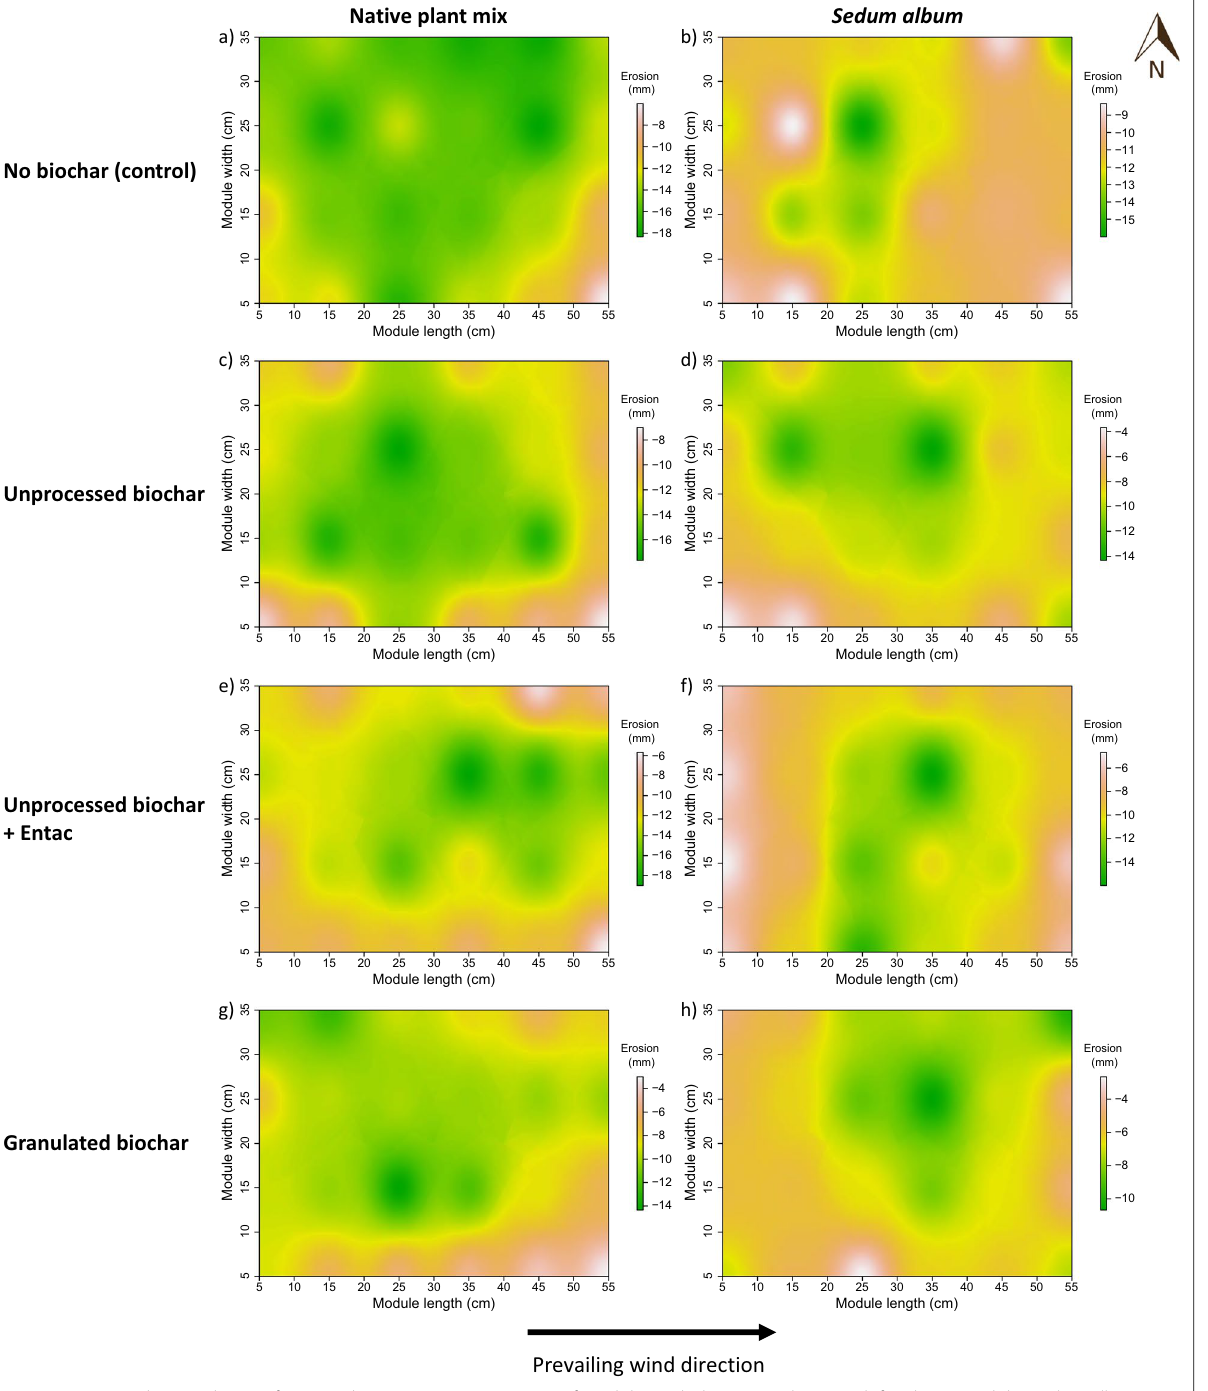
Fig. 5 IDW spatial interpolation of mean substrate erosion in green roof modules with the native plant mix (left column) and the Sedum album (right column) for the control ( a , b ), unprocessed biochars ( c , d ), unprocessed biochars with Entac ™ ( e , f ), and granulated biochars ( g , h ). Negative values indicate substrate erosion. Substrate erosion is based on measurements on 3 replicates for each biochar treatment and the control. White and green colors indicate low and high substrate erosion, respectively. The black arrow indicates the prevailing wind